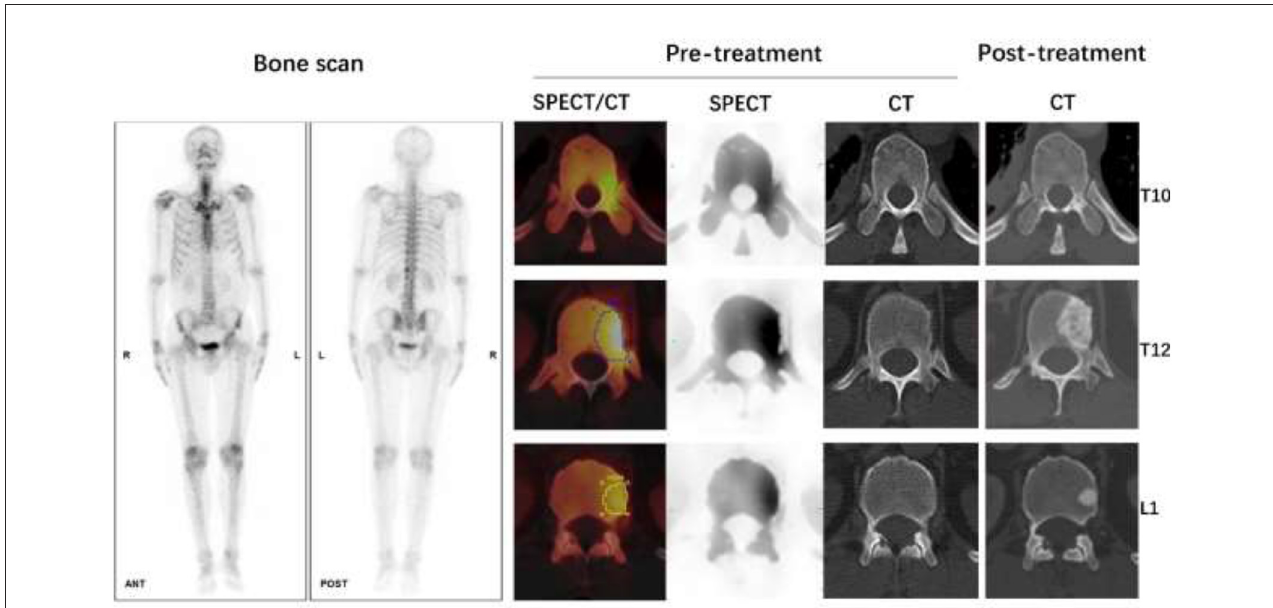
FIGURE6 Male, 62 years old, CT guided biopsy of a tumor in the lower lobe of the right lung revealed a moderately differentiated adenocarcinoma, with an EGFR 19 mutation. Before treatment, a full-body bone scan revealed suspicious metastasis of the T10, T12, and L1 vertebrae. The SUVmax of lesions on T10, T12, and L1 vertebrae were 9.71, 14.80, and 10.52 g/ml, respectively, according to quantitative SPECT/CT. But the CT scan of these vertebrae on pre-treatment images showed no abnormal bone density changes. After 4 months of Almonertinib therapy, a post-treatment CT scan revealed increased bone mineral density in the high uptake area of SPECT images, confirmed bone metastasis of these